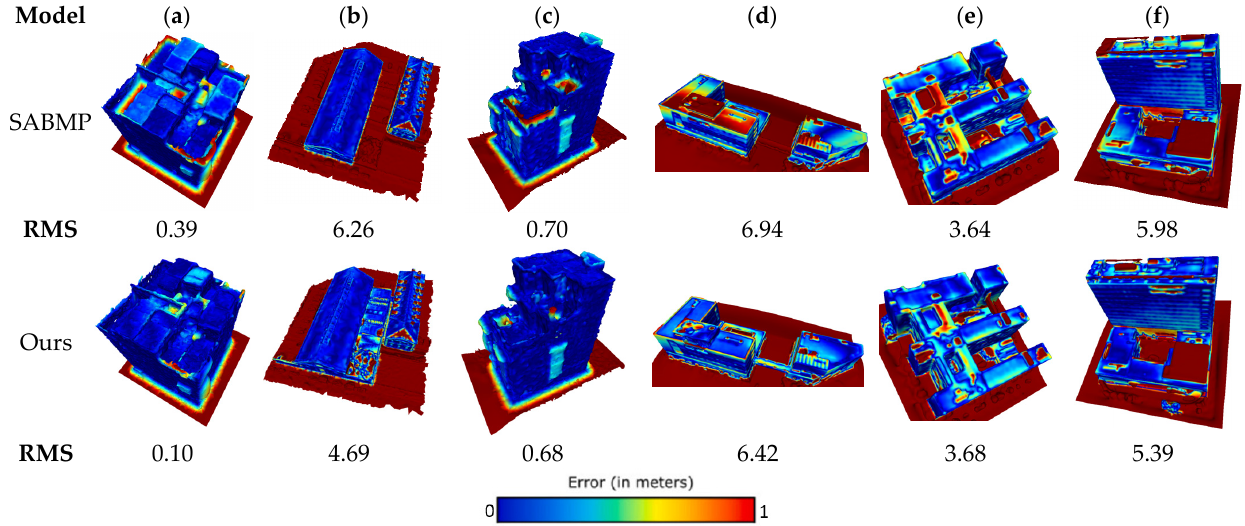
Figure 13. Accuracy comparison results of SABMP model ( a – f ). The error of more than 1 m is also shown in red.